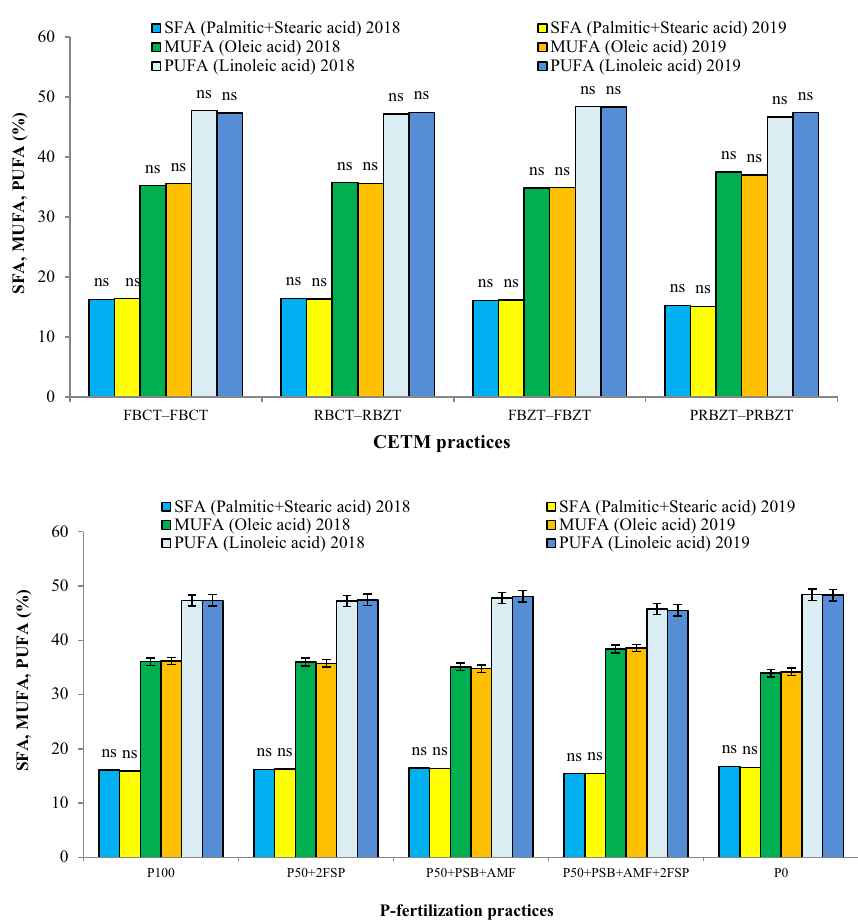
Figure 3. Influence of CETM and P-fertilization practices on fatty acid composition viz. SFA [Saturated fatty acid (Palmitic acid + Stearic acid)], MUFA [Mono unsaturated fatty acid (Oleic acid)] and PUFA [Poly unsaturated fatty acid (Linoleic acid)] in maize under MWCS. The vertical bars represent LSD 0.05